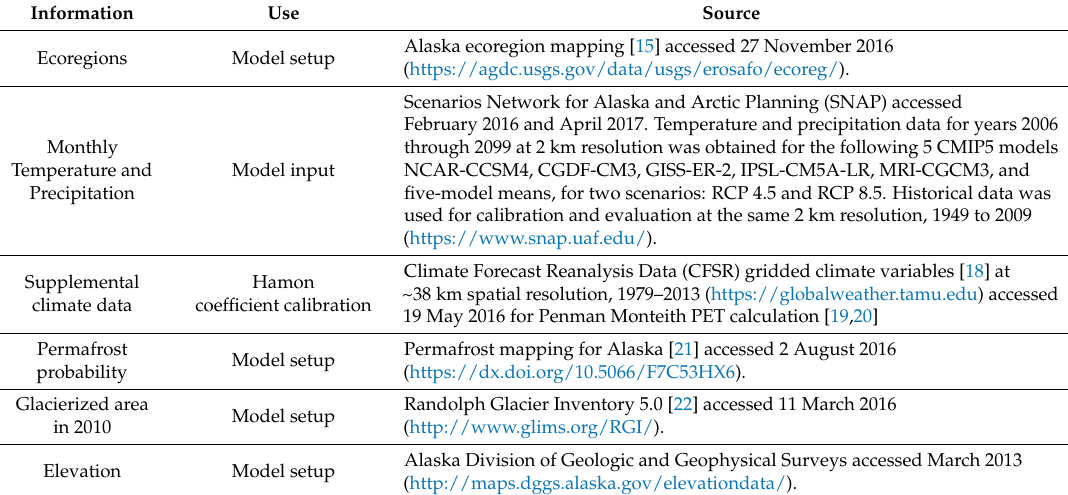
Table 1. Sources of data.